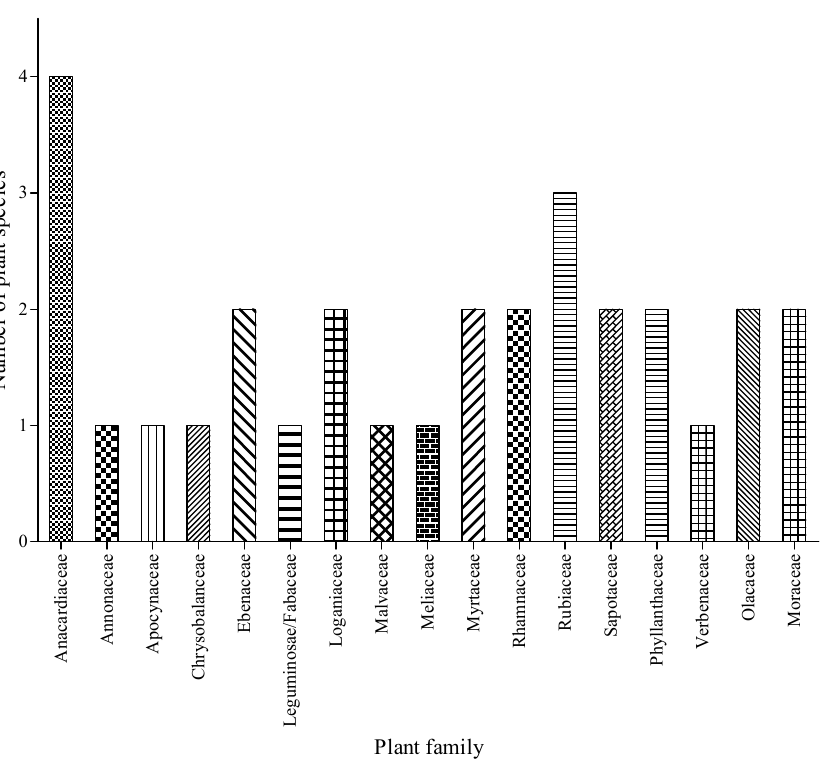
Figure 2. Families of fruit species identified in three villages of Bushbuckridge Local Municipality, Mpumalanga province, South Africa.